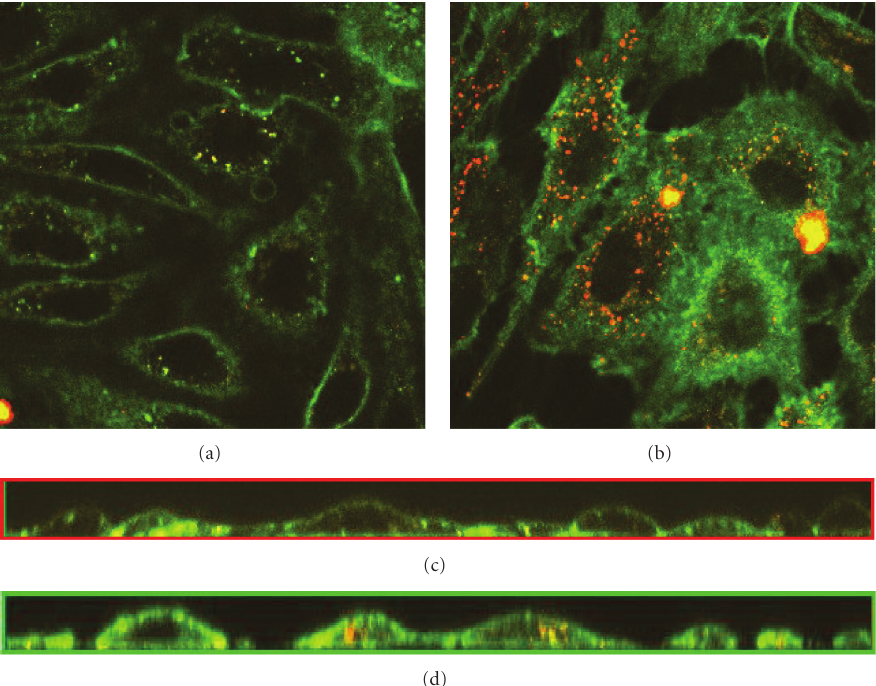
Figure 6: E ff ect of PAO on uptake of LDL by PAEC grown under static conditions. The glycocalyx layer is visualized under the confocal microscope through staining of heparan sulfate with FITC-conjugated lectin (green) and LDL added as DiI complex (red) after di ff erent times in culture. (a) Cells grown under static conditions for 24 hours and incubated with PAO together with FITC-conjugated lectins and (b) cells grown under static conditions for 24 hours. Internalized LDL appear yellow when colocalized with heparan sulfate stain. (c) Cross- sections of image stacks created with confocal microscopy of (a) and (d) cross-sections from the side of the stack of images of